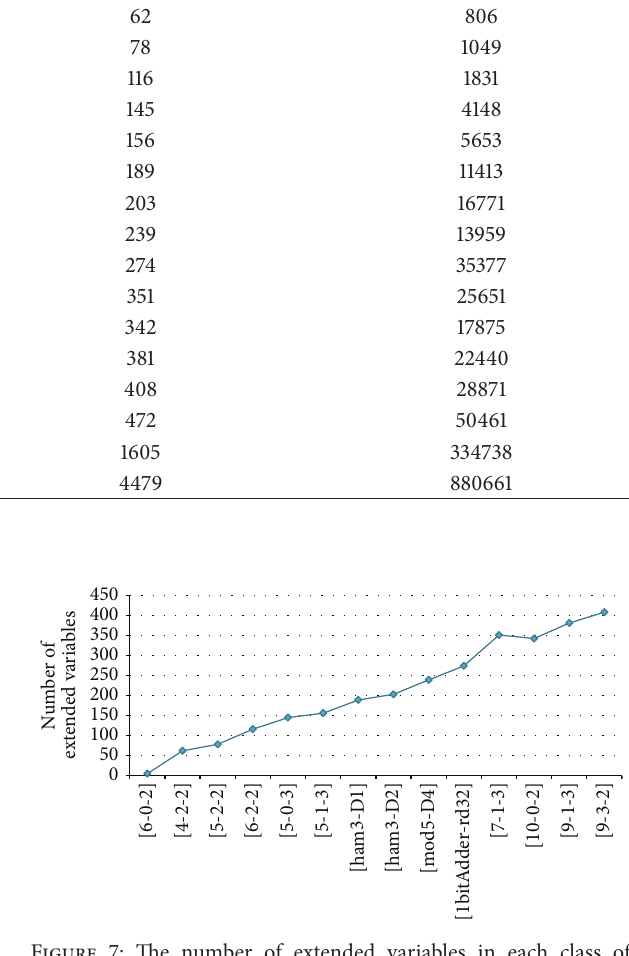
Figure 7: The number of extended variables in each class of